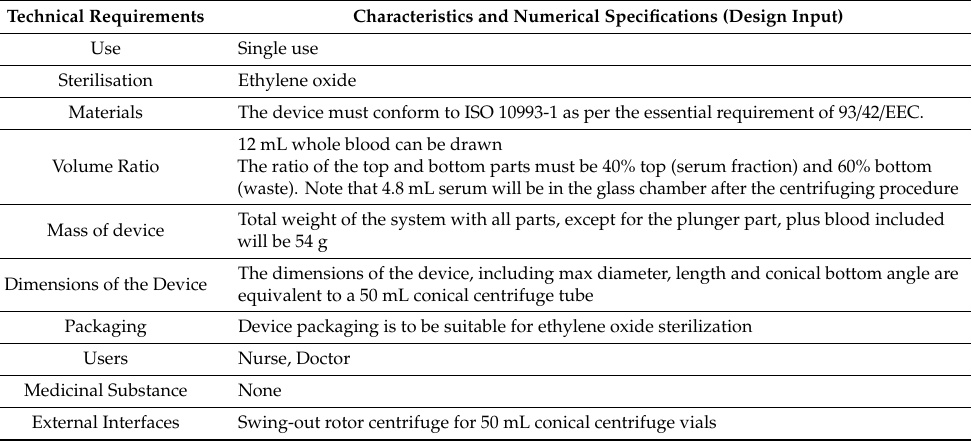
Table 1. Functional requirement